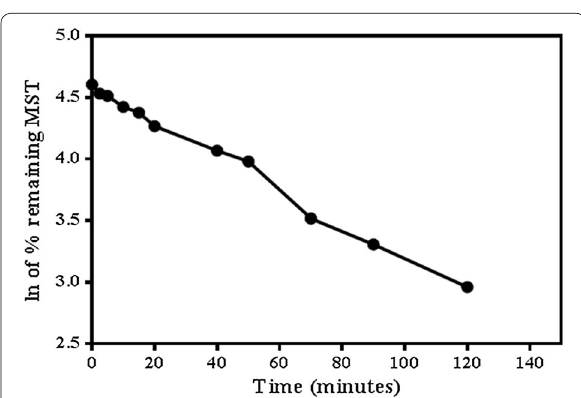
Fig. 4 The metabolic stability profile of MST after incubation with RLMs. Metabolic reaction was stopped at different time points